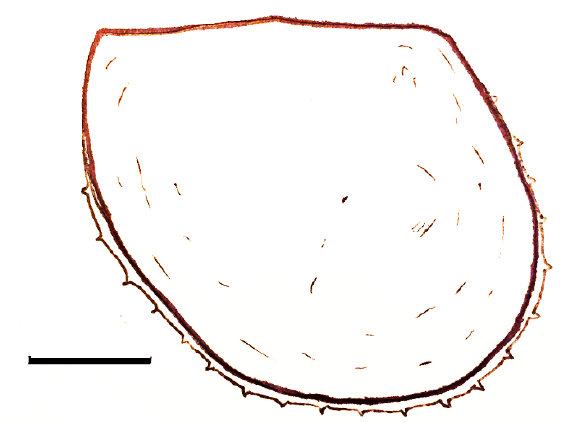
Figure 30. Zepaera jagoi . Anterior to left. Scale bar 200 microns. Image Credit: Mark McMenamin.